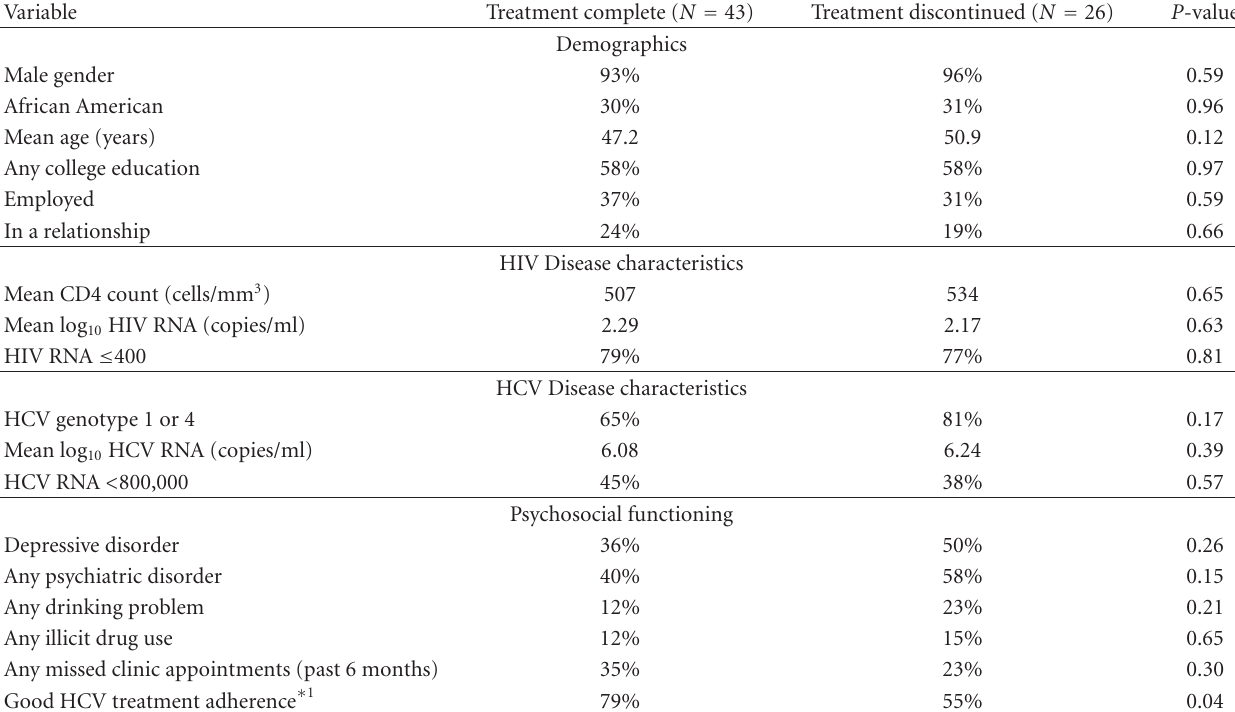
Table 2: Patient characteristics and HCV treatment